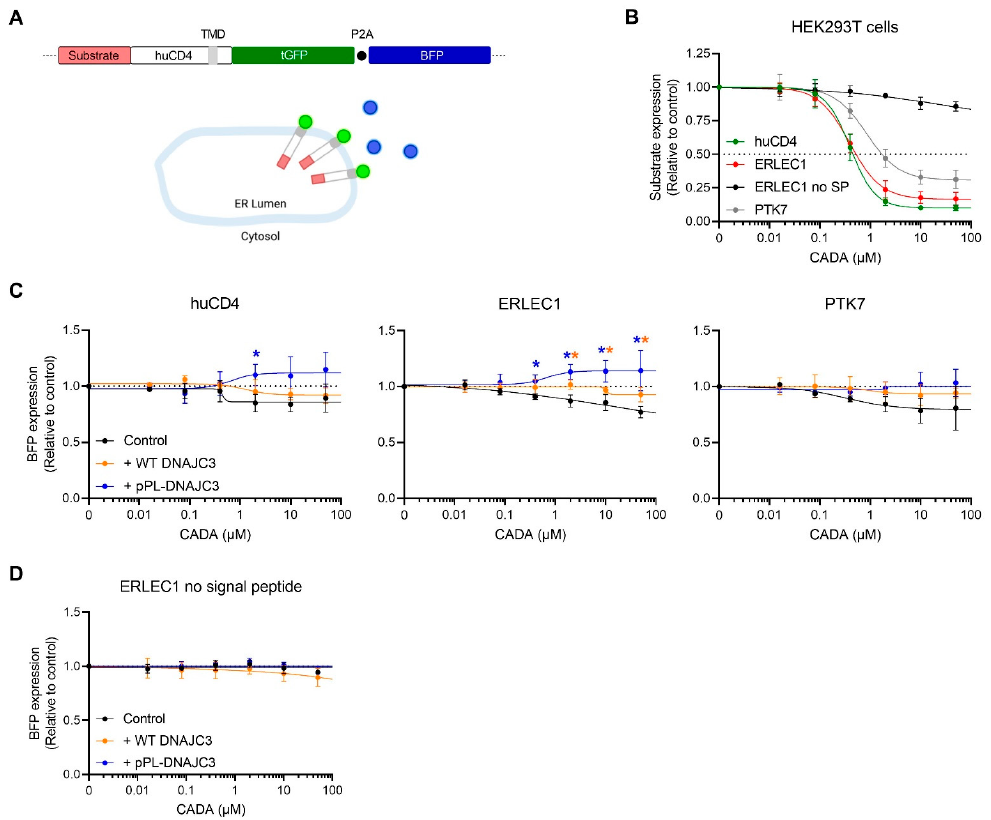
Figure 5. DNAJC3 differentially affected BFP expression in the presence of CADA-stalled proteins. ( A ) Representation of the tGFP-P2A-BFP construct. The construct expressed huCD4 that was anchored in the plasma membrane via its transmembrane domain (TMD) and with tGFP at the cytosolic tail. As the SP was cleaved by the ER lumenal signal peptidase during protein biogenesis, the mature huCD4 variants differed in only 62 amino acids at their N-terminus. ( B ) Four-parameter concentration–response curves for the CADA of huCD4, ERLEC1, ERLEC1 with no SP, and PTK7 cloned in the same tGFP-P2A-BFP plasmid backbone as shown in ( A ). HEK293T cells were transiently transfected with the tGFP-P2A-BFP constructs and incubated with different CADA concentrations for 24 h. Transfected tGFP-P2A-BFP plasmid DNA was equal to the transfected tGFP-P2A-BFP plasmid DNA in the co-transfected conditions of ( C , D ). Protein levels of tGFP (representing the level of substrate) in CADA-treated samples were normalised to the DMSO control (set at 1.00). Curves were fitted to data from three to five replicate experiments. Values are mean ± SD; n ≥ 3. ( C ) Four-parameter concentration–response curves for CADA of the BFP signal of huCD4, ERLEC1 and PTK7 cloned in the same tGFP-P2A-BFP plasmid backbone as shown in ( A ). HEK293T cells were transiently transfected with the tGFP-P2A-BFP construct, or co-transfected with the tGFP-P2A-BFP construct and WT DNAJC3 or pPL-DNAJC3 and incubated with different CADA concentrations for 24 h. Transfected tGFP-P2A-BFP plasmid DNA was equal to the transfected tGFP-P2A-BFP plasmid DNA in the co-transfected conditions. BFP levels in CADA-treated samples were normalised to the DMSO control (set at 1.0). Curves were fitted to data from three to five replicate experiments. Values are mean ± SD; n ≥ 3. Statistical analysis (multiple unpaired t -tests) showed significantly increased expression of BFP for huCD4 and ERLEC1 when co-expressed with pPL- DNAJC3 and for ERLEC1 when co-expressed with WT DNAJC3 as compared to the control (* = p < 0.05). ( D ) Same as in ( C ). Four-parameter concentration–response curve for the CADA of the BFP signal of ERLEC1 with no SP cloned in the tGFP-P2A-BFP plasmid backbone. Curves were fitted to data from three replicate experiments. Values are mean ± SD; n = 3. tGFP: turbo green fluorescent protein; BFP: blue fluorescent protein; huCD4: human CD4; SP: signal peptide; CADA: cyclotriazadisulfonamide; ERLEC1: endoplasmic reticulum lectin 1; PTK7: inactive tyrosine-protein kinase 7; HEK293T: human embryonic kidney 293T cells; DMSO: dimethyl sulfoxide; pPL: pre-prolactin; DNAJC3: DnaJ homolog subfamily C member 3; TMD, transmembrane